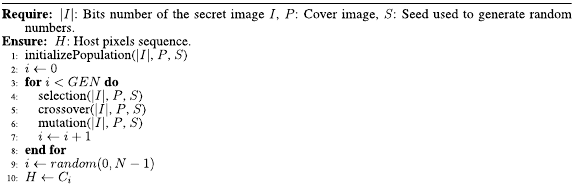
Algorithm 1. Genetic algorithm for host pixels selection.